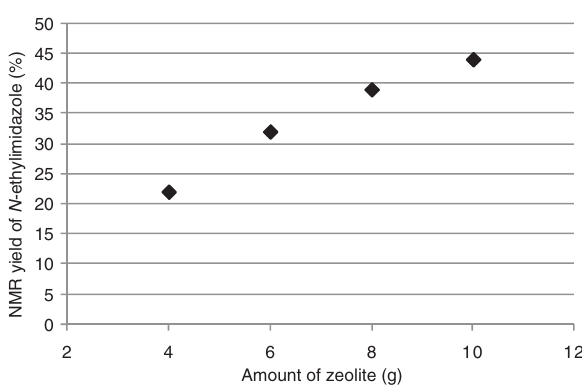
Figure 2: Effect of catalyst amount on the reaction of imidazole and ethanol. Reaction conditions: 1 m solution, 300 ° C, 90 bar, 1 ml/min flow rate. Residence time was kept at 13 min in each